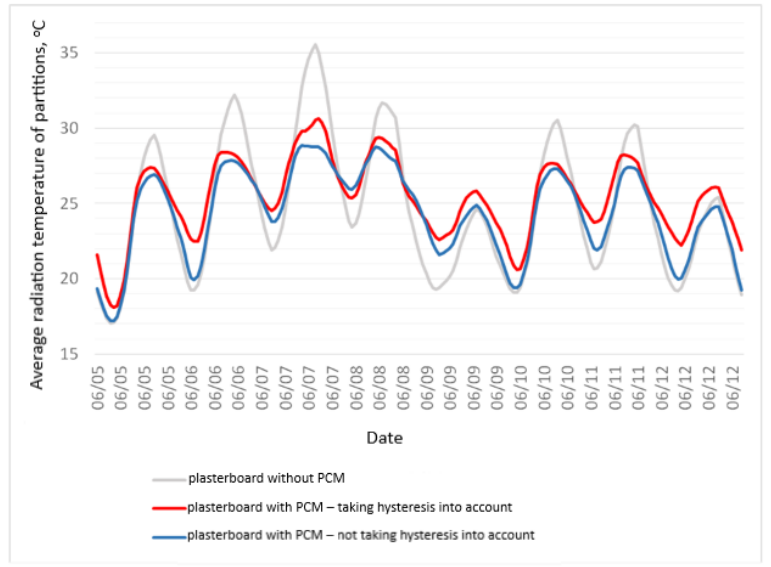
Figure 8. Average hourly values of radiation temperature of partitions inside a building with plasterboards in the period 5 June – 12 June.